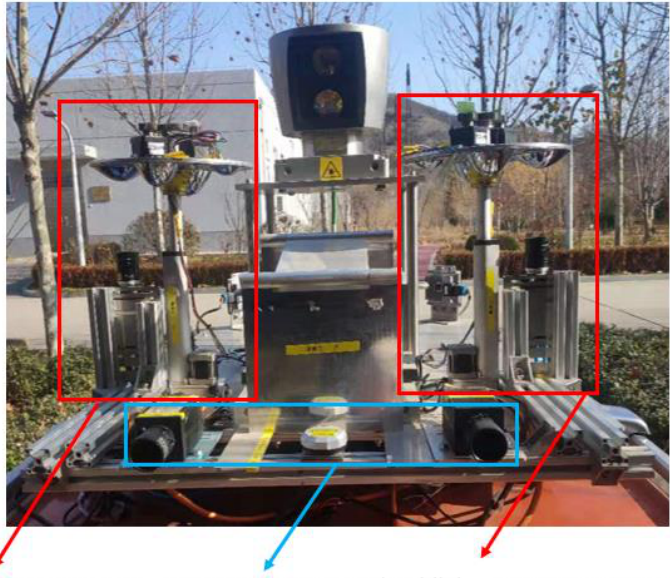
Figure 8. Physical map of binocular stereo panoramic vision systems.